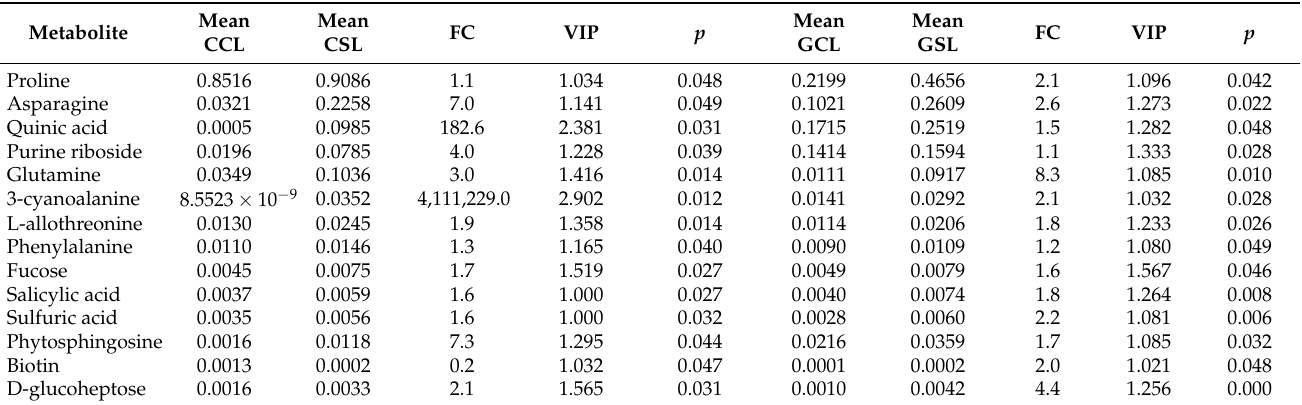
Table 2. Common central metabolites in cherry